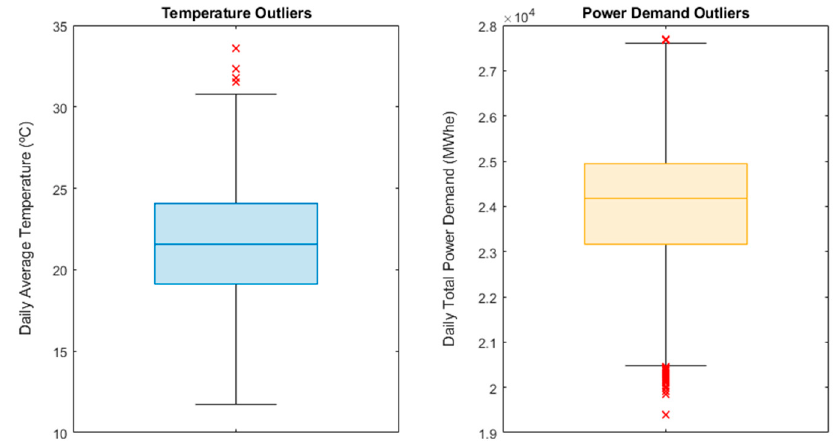
Figure 9. Tukey test results.